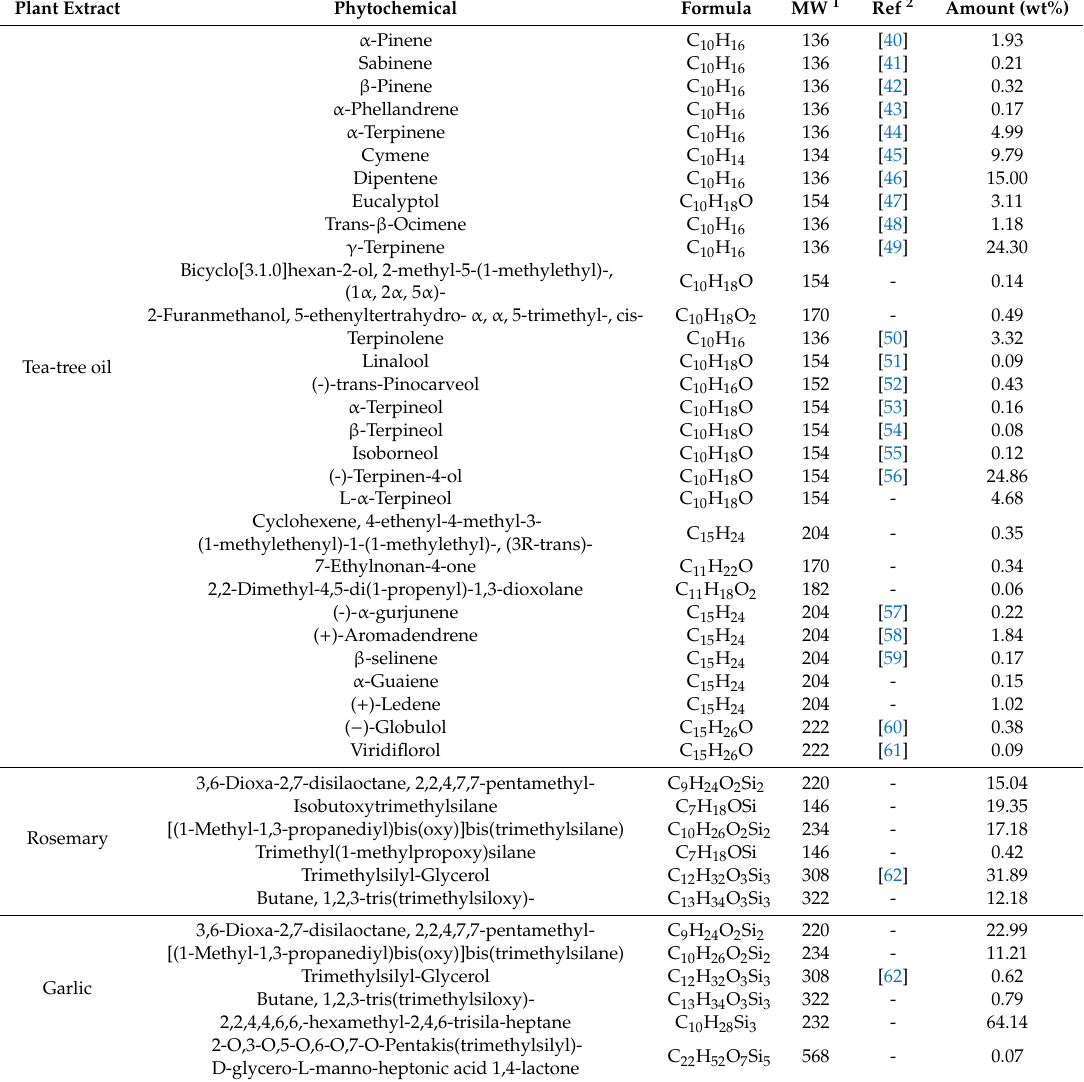
1 MW: molecular weight 2 Ref: antimicrobial activity